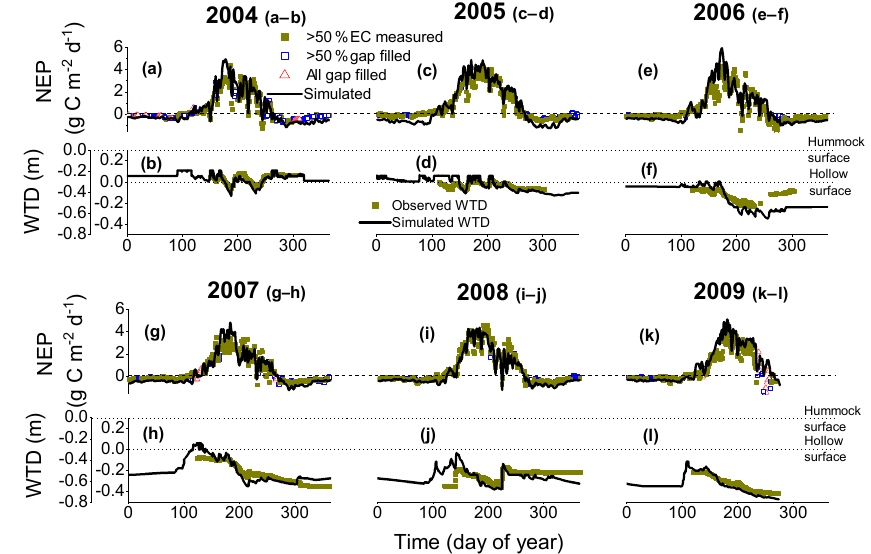
Figure 3. (a, c, e, g, i, k) Three-day moving averages of modeled and EC gap-filled (Flanagan and Syed, 2011) NEP and (b, d, f, h, j, l) hourly modeled and half-hourly measured (Syed et al., 2006; Cai et al., 2010; Long et al., 2010; Flanagan and Syed, 2011) WTD from 2004 to 2009 at a western Canadian fen peatland. A positive NEP means that the ecosystem is a carbon sink, and a negative NEP means that the ecosystem is a carbon source. A negative WTD represents a depth below hummock/hollow surface, and a positive WTD represents a depth above hummock/hollow surface.